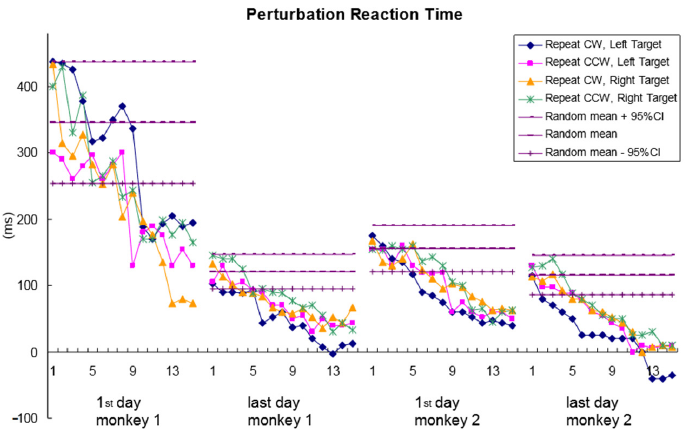
Figure 5. Perturbation reaction time. Mean RTp for different perturbation conditions across consecutive trials on the first and the last perturbation days for the two monkeys. There are seven data lines for each day. The three horizontal lines show the mean RTp (middle) for all the random perturbation trials recorded on that day with 95% confidence intervals (top and bottom lines). Each curved line shows the mean RTp across 15 consecutive trials for one repeat perturbation condition. Each data point was averaged from the RTp of the same trial for the same condition in different blocks recorded on that